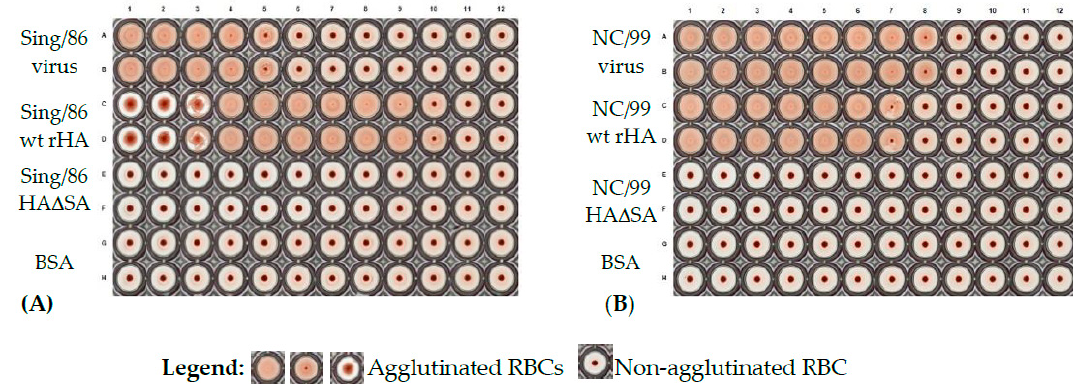
Figure 6. Hemagglutination activity of rHA expressed by stably-transfected cell lines. Representative wild type rHA and corresponding HA Δ SA from Sing/86 ( A ) and NC/99 ( B ) were evaluated for their ability to agglutinate turkey RBCs. All proteins were tested in duplicate starting from 50 µg/mL and two-fold serially diluted (from left to right). BSA was used as negative control and the corresponding influenza viruses from Sing/86 and NC/99 were used as positive controls.